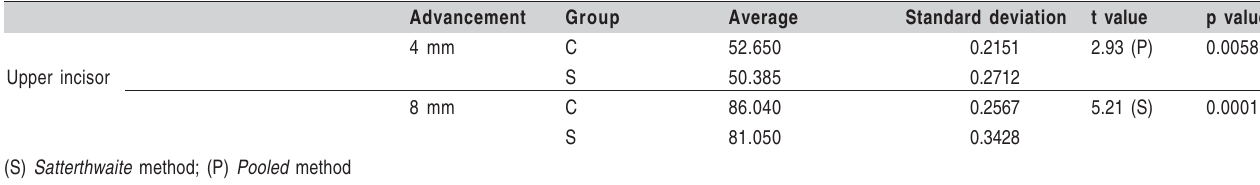
Table 2. Average, standard deviation, and student t test for comparison of anteroposterior variable from analyzed groups in advancement of 4 and 8